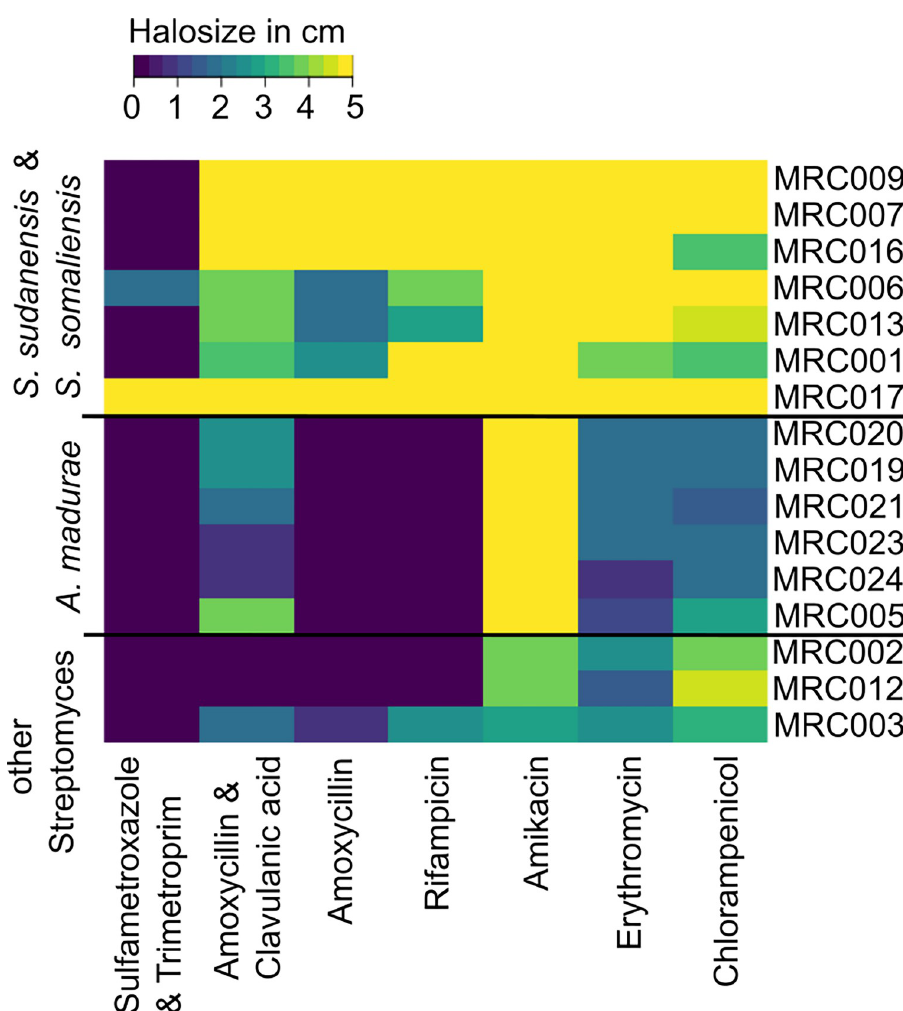
Fig 7. Comparative antibiotic susceptibility profiles of actinomycetoma isolates based on a disk diffusion assay. Halo size was recorded in cm. Yellow low IC. Blue high IC. The isolates were grouped using hierarchical clustering based on their IC profiles using the default parameters of heatmap2 in